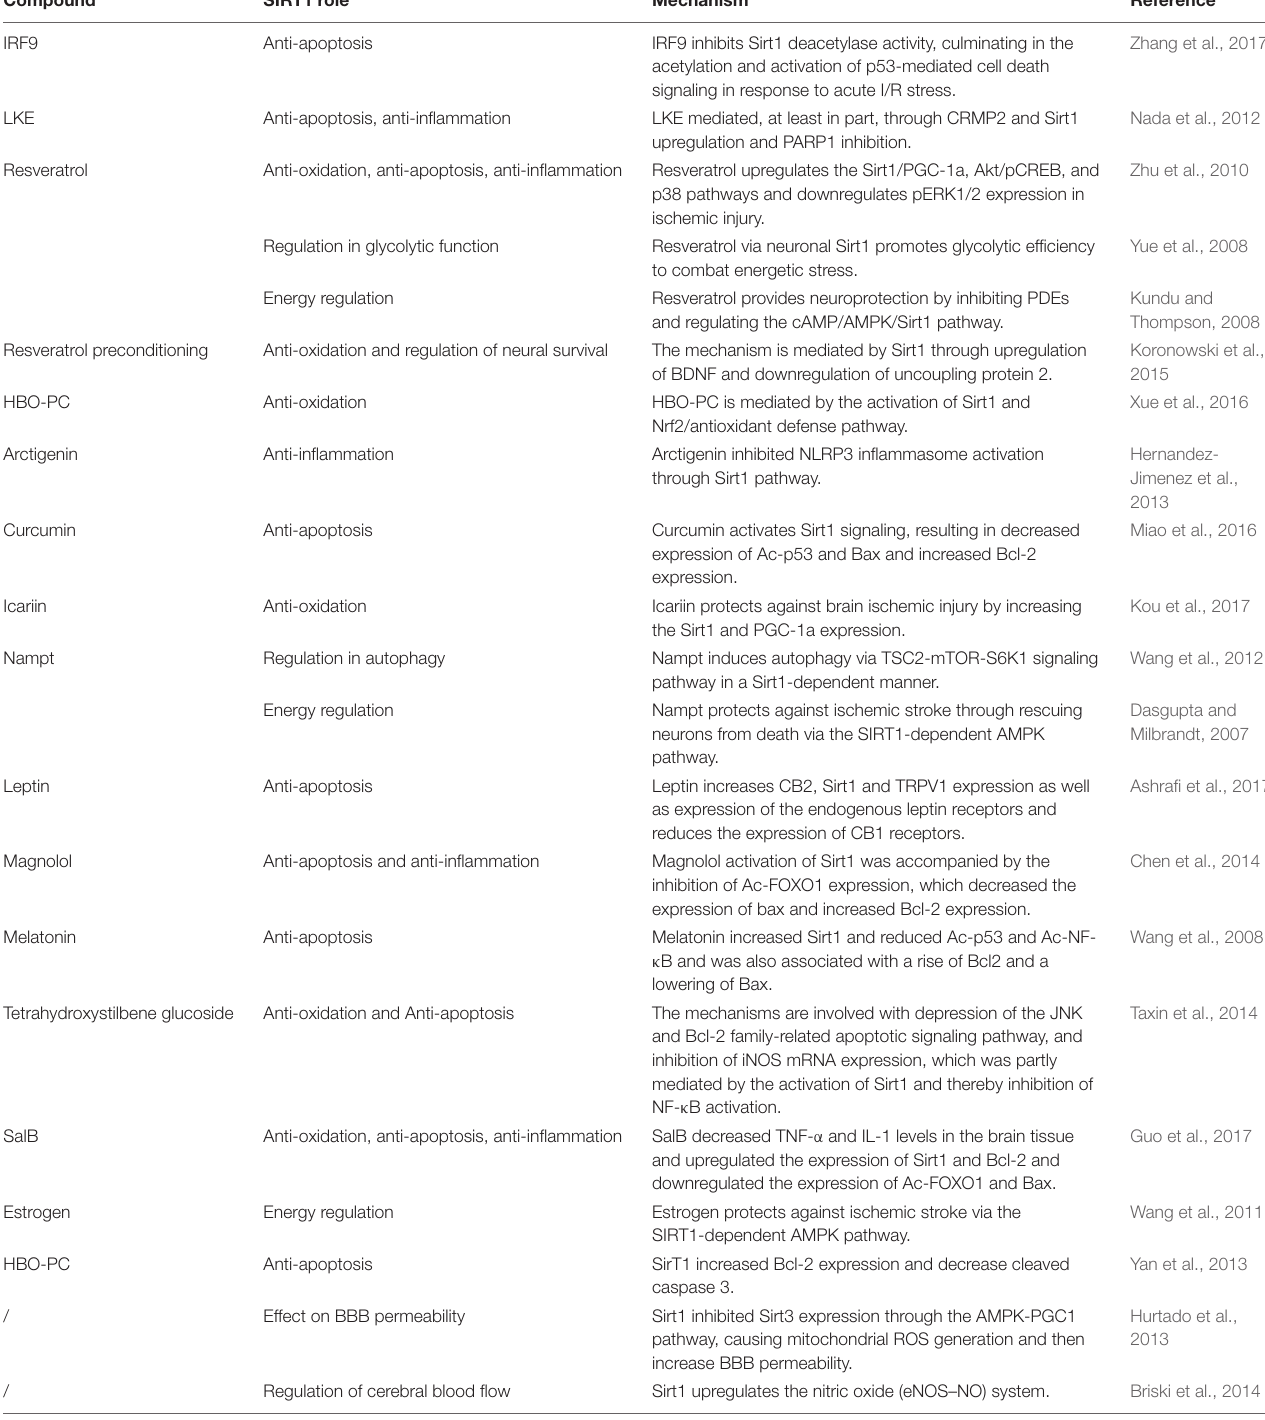
TABLE 1 | Role and mechanisms of Sirt1 in ischemic